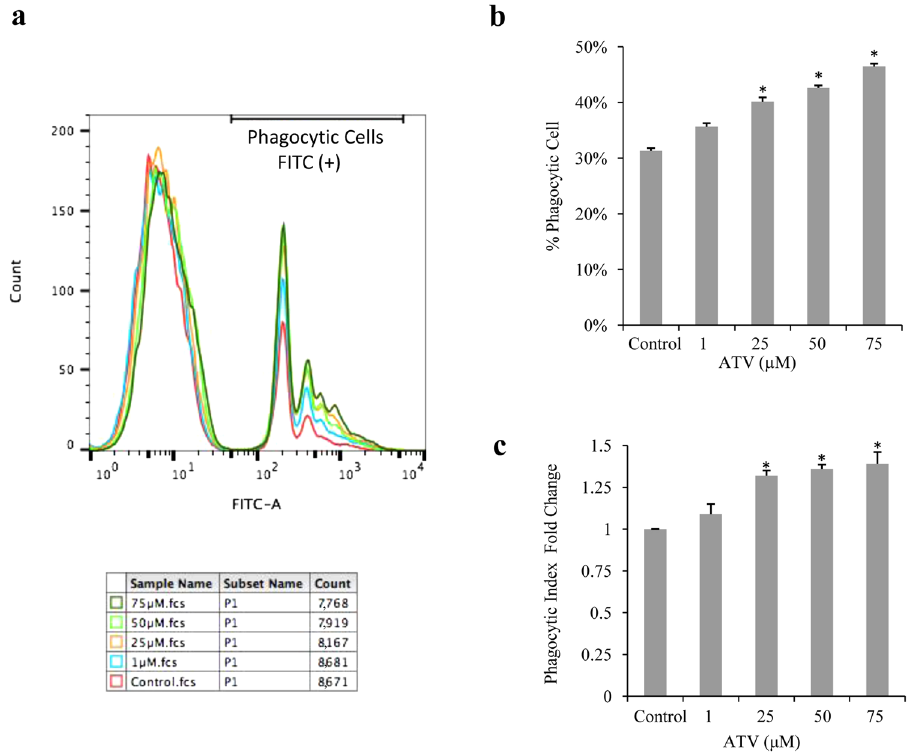
Figure 2. Atorvastatin increases the phagocytic function of ARPE-19 cells in a dose-dependent manner. ( a ) Count of phagocytic cells (Y axis), represented by number of FITC-positive cells, and fluorescence intensity (X axis), as determined by flow cytometry of ARPE-19 cells incubated with fluorescein-labeled carboxylate microspheres and treated with different concentrations of atorvastatin. ( b ) Quantification of the percentage of phagocytic cells shown in ( a ). ( c ) Quantification of the fold change of phagocytic index (or mean fluorescence intensity). The results are expressed as mean ± SE. * p < 0.05 versus control group.